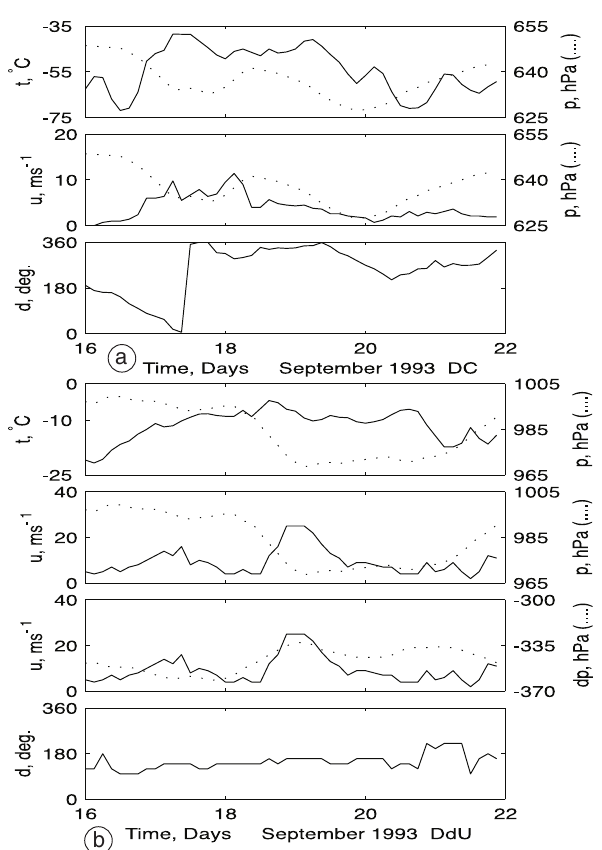
Fig. 8a,b. Time series of meteorological parameters for: a) Dome C showing strong wind event around 18 September 1993; b) Dumont d’Urville depicting strong wind event around 19 September 1993,